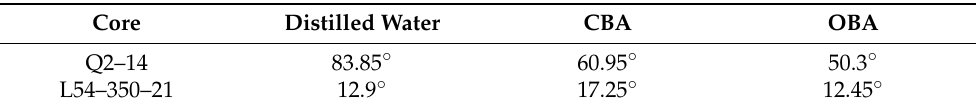
Table 4. Contact angles of oil–displacement agents.